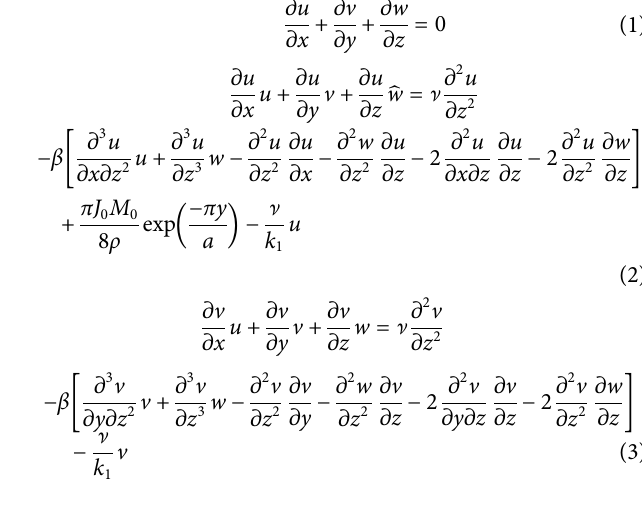
TABLE 2 | Illustrating the disparity of − f ′′ ( 0 ) and − g ′′ ( 0 ) with c when K (cid:1) Q (cid:1) Λ (cid:1) 0.0 from Qayyum et al. [25] and Li et al. [26]. − f 99 ( 0 ) Reference [25] Reference